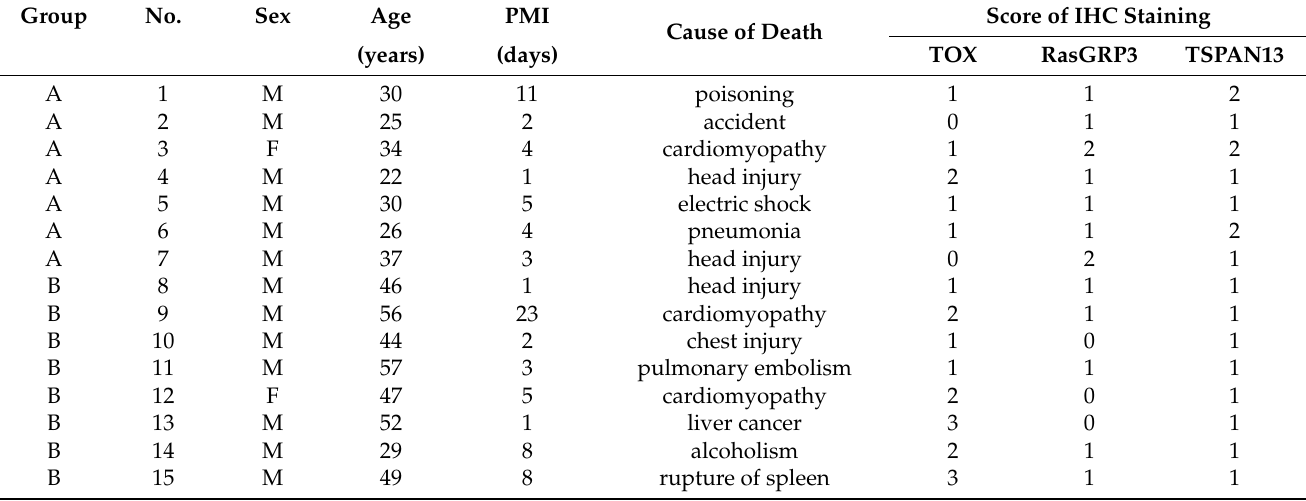
Table 1. Detailed characteristics of the study collective for IHC